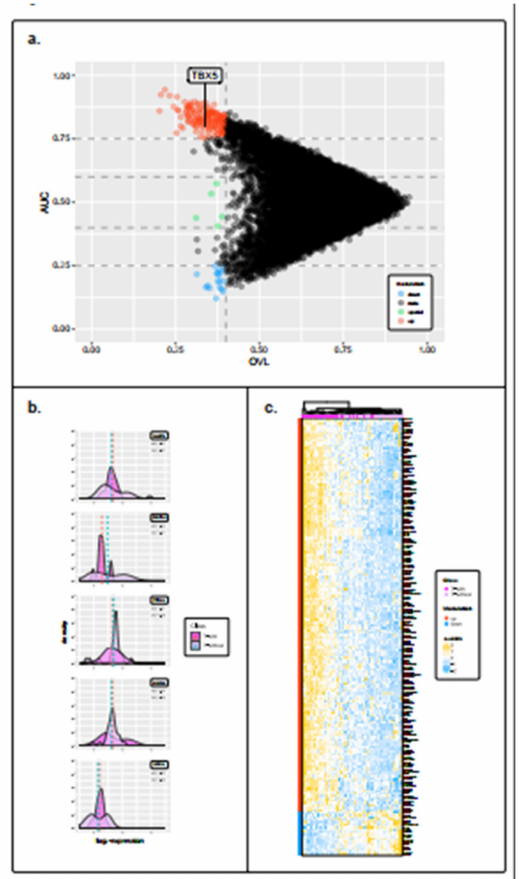
Figure 2. Identification of significantly di ff erentially expressed genes between the T-with and T-without tumors. ( a ) Arrow plot showing genes in the OVL–AUC plane, whose dimensions represent the overlapping coe ffi cient and the area under the ROC curve, respectively. We considered as genes of interest those with an OVL < 0.4. Specifically, these were genes with an AUC > 0.75 (up-regulated in the T-with group, red dots) or genes having an AUC < 0.25 (down-regulated in the T-with group, blue dots). Genes having 0.4 < AUC < 0.6 are referred to as special (green dots), since they had the same mean expression levels between the T-with and T-without groups, but also had very di ff erent data distributions. ( b ) Density plots showing the distributions of the five special genes (NUDT6, COX7A1, TTC19, SNRPA1, and UFD1L). ( c ) Heatmap clustered by Euclidean distance and the complete linkage method representing gene expression levels of the up- and down-regulated genes in the T-with and T-without groups. On the left of the figure the red and blue bars specify whether the genes are up- or down-regulated respectively, while on the top, the magenta and light pink squares indicate whether the samples belong to the T-with or T-without groups respectively. Gene expression levels colors range from blue (low expression), to white (mild expression), to yellow (high